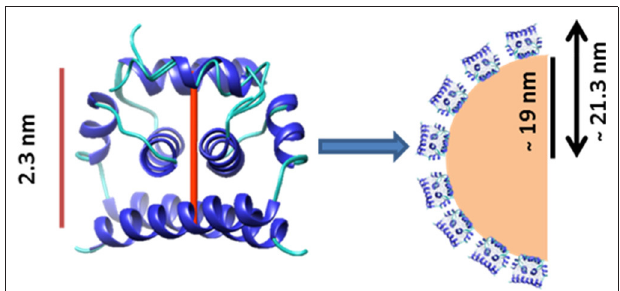
FIGURE 4 | Proposed model of WNV C interaction with VLDL. WNV C dimensions fit well with the observed increase of ∼ 2.3nm on the VLDL hydrodynamic radius. Without WNV C, VLDL present a hydrodynamic radius of ∼ 19nm, while with 5 µ M WNV C it increases to ∼ 21.3nm. Therefore, a monolayer of WNV C molecules could be formed on the VLDL